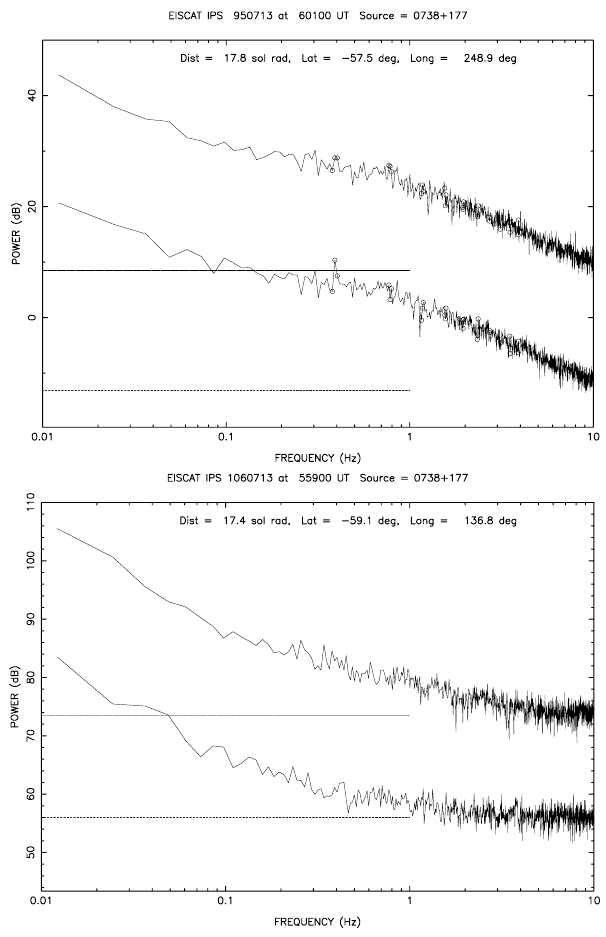
Fig. 1. Power spectra of IPS measurements of the radio source J0738+177 taken on 13 July (a) 1995 and (b) 2006. In each case the top spectrum is of data taken by the Kiruna site and the bot- tom spectrum is of data taken at Sodankyl¨a. The horizontal dotted and dashed lines represent the level of background white noise for each spectrum. The power is given in decibels and the frequency displayed